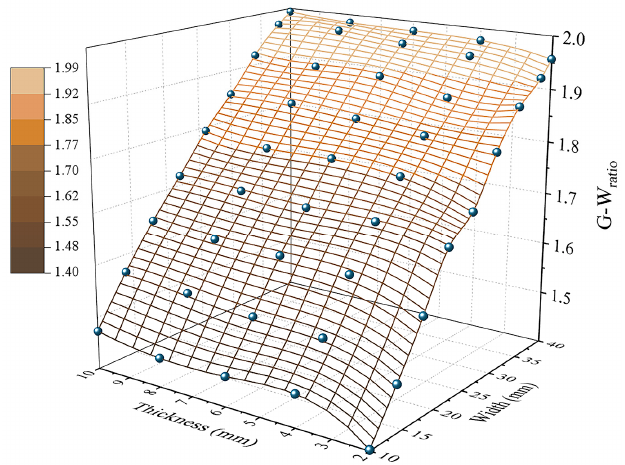
Figure 11. The G-W ratio varies with respect to thickness and width.